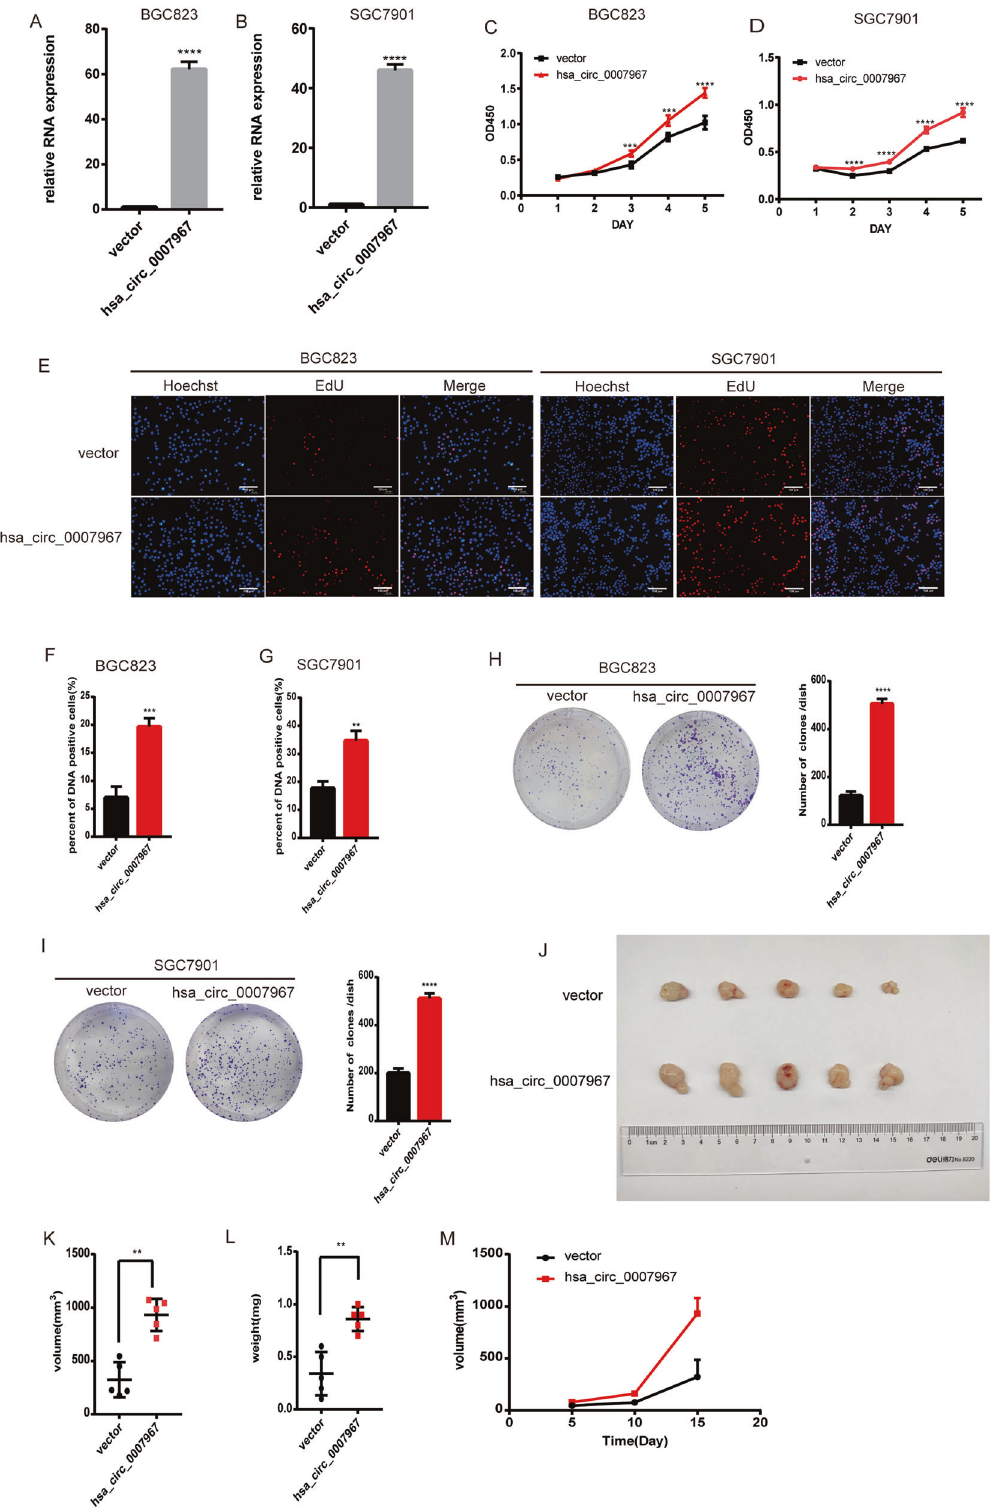
Fig. 2 Overexpressing hsa_circ_0007967 promotes GC proliferation in vitro and in vivo. A , B The expression of hsa_circ_0007967 in BGC823 and SGC7901 cells transfected with vector and hsa_circ_0007967 plasmids. C , D The growth rate of BGC823 and SGC7901 cells transfected with vector and hsa_circ-0007967 by cck8 assays. E EdU assays of BGC823 and SGC7901 cells transfected with vector and hsa_circ- 0007967 plasmids. F , G DNA positive cells of BGC823 and SGC7901 cells transfected with vector and hsa_circ-0007967 by EdU assays. H , I The assessment of proliferation of BGC823 and SGC7901 cells transfected with vector and hsa_circ_0007967 plasmid by colony formation assays. J – L Tumors from mice in two different groups, and the weight and volume of tumors at the end point. M The weight of tumors measured every 5 days until the end point.